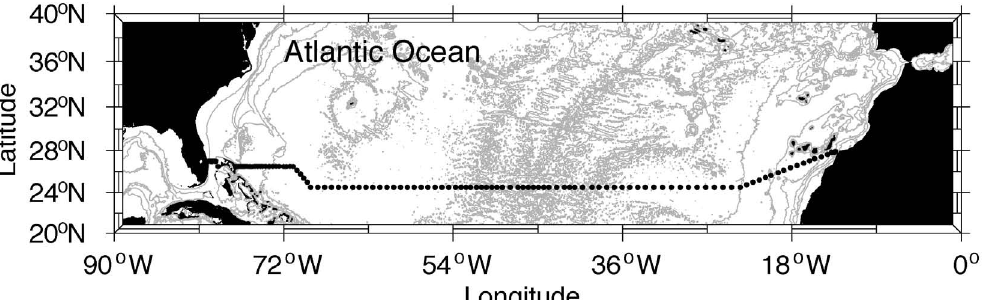
Fig . 1. – Station positions for the transatlantic hydrographic section occupied during cruise D279. 125 full depth stations were used along a nominal latitude of